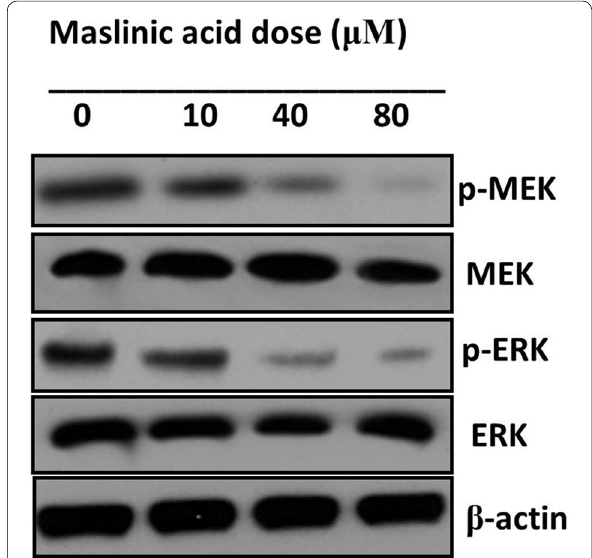
Fig. 10 Expressions of proteins associated with MAPK/ERK signaling pathway in SHSY-5Y cells after test drug treatment. For maximum precision three individual experiments were